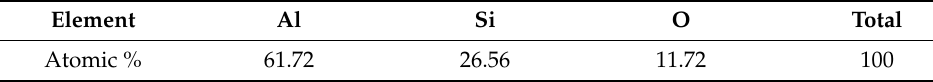
Figure 3. ( a ) SEM image of the sensor, scale bar 200 µm. ( b ) SEM image, scale bar 10 µm, with a marked area where EDS analysis was performed. Table 1. Atomic composition of the sensor